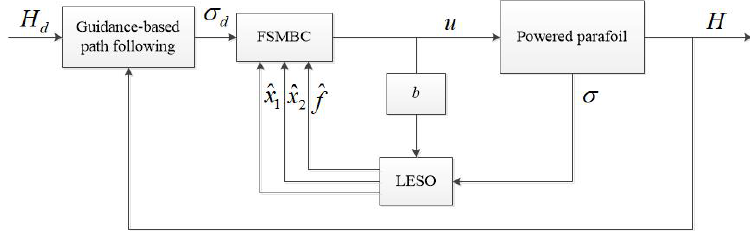
Figure 2. Configuration of the control system of the powered